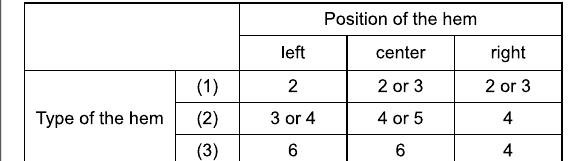
Fig. 7 The relationship between the type of hems, the position and the number of edges when only one hem is visible from the camera. The number (1)–(3) means three types of hem explained in “Orienta- tion estimation of cloth products” section